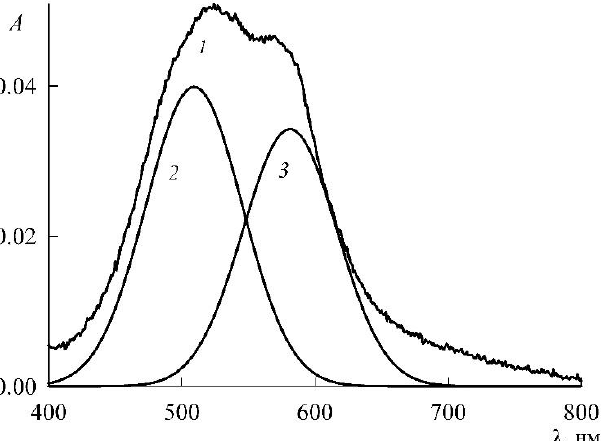
Figure 12. An example of decomposition of Curve 1 on Figure 11 in two components ( 2 and 3 ).